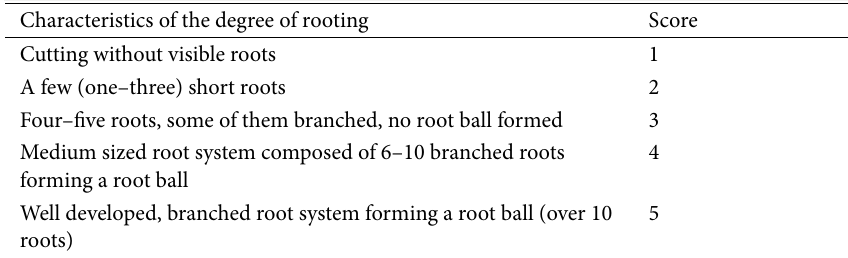
Table 2 Evaluation scale of root